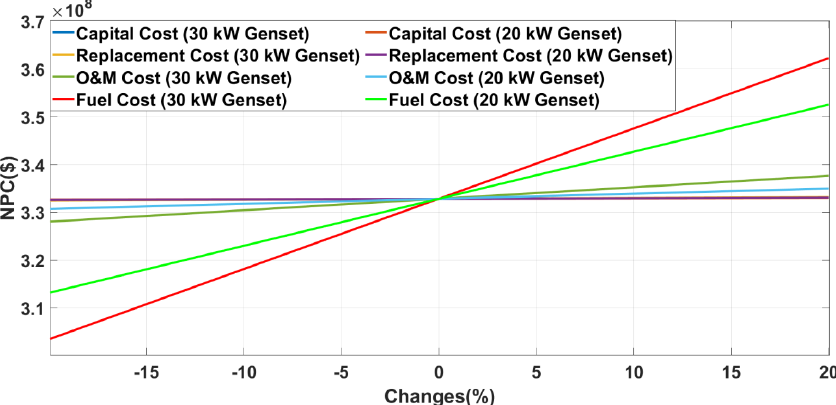
Figure 22. Impact on NPC due to variation in diesel genset cost.